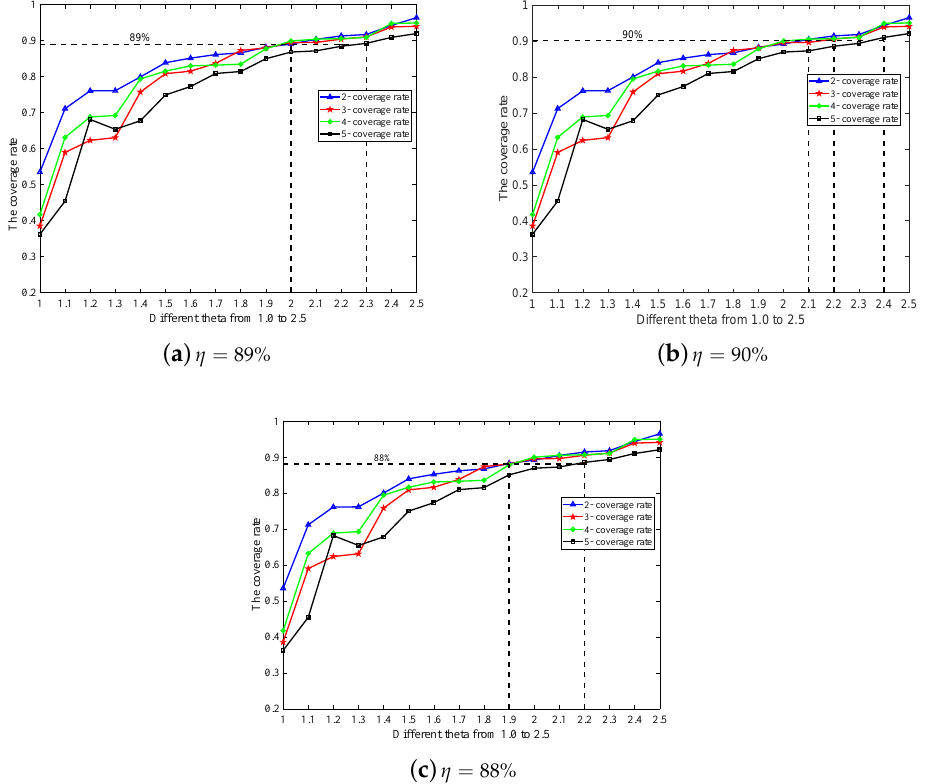
Figure 3. The simulation results of the coverage rate with different values of k and θ ( k , η ) . ( a ) η = 89%; ( b ) η = 90%; ( c ) η =